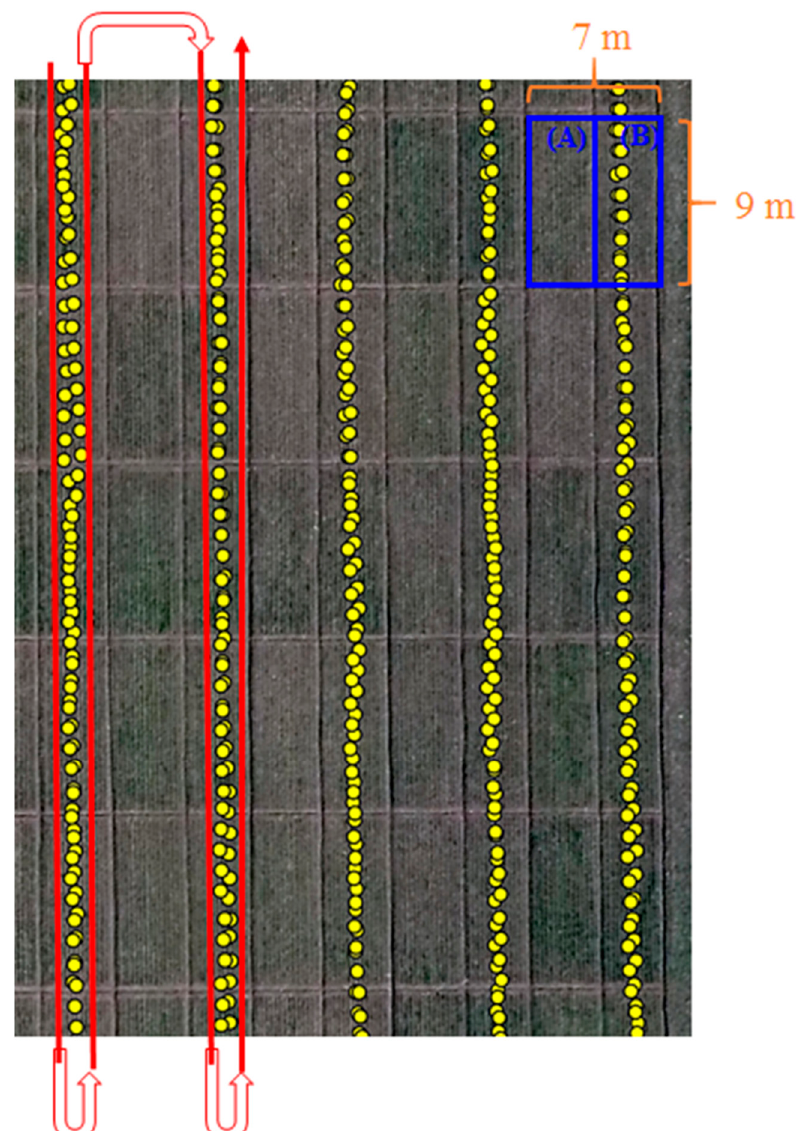
Figure 2. Image produced by the registration between Global Positioning System (GPS) information of experiment field (Exp. 4) and geographic-location information of spectral data. Note: Yellow points represent data collected by the UAV equipped with a RapidSCAN CS-45 sensor. The blue box represents the plot; in order to improve drainage, the plot was divided into two same sections: A and B, which are used for plant sampling and spectral data collection, respectively. The red lines just represent the UAV flight path direction, while the flight routes align with the central axis of each plot. Table 2. Vegetation indices used for the RapidSCAN CS-45 sensor.